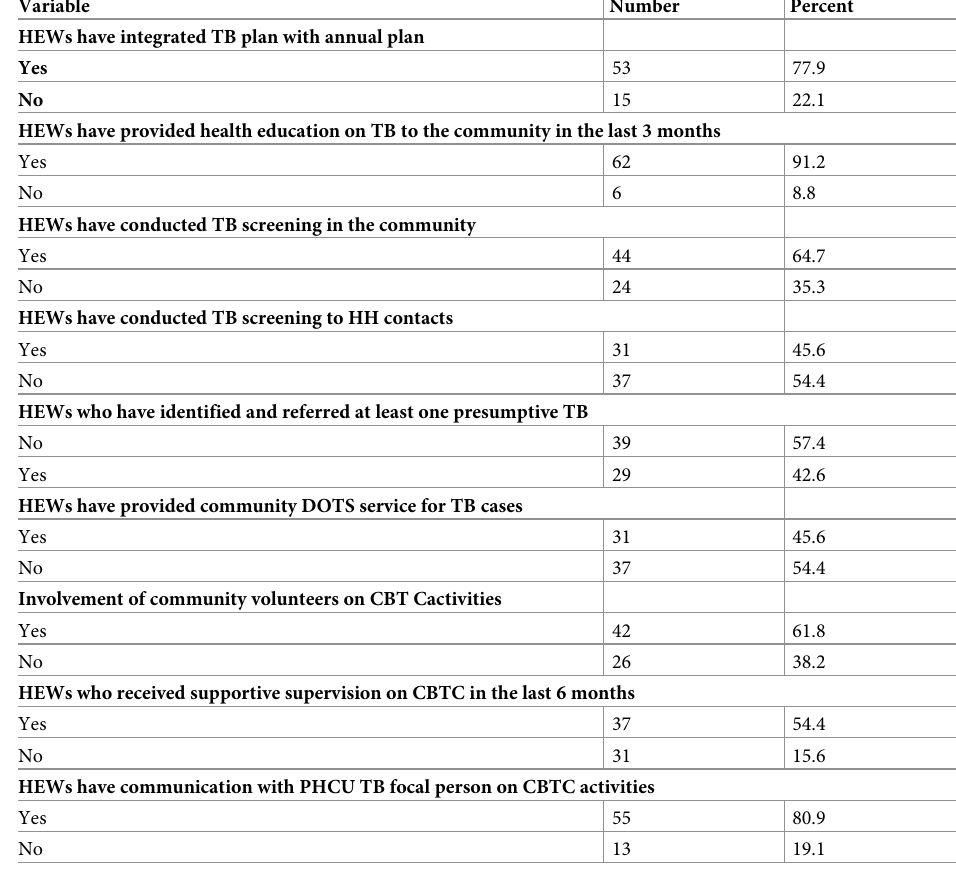
Table 2. Implementation of CBTC activities, in Tigray region, Northern Ethiopia, 2018 (N = 68).